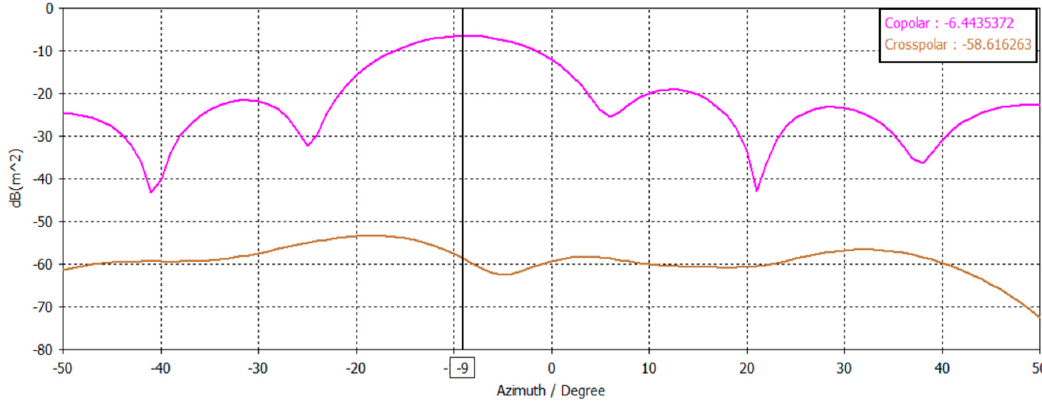
Figure 8. Results of far-field co-polarization and cross polarization for beam steering at 28 GHz in the three-stripe configuration. Steering angle simulation results of 9°.